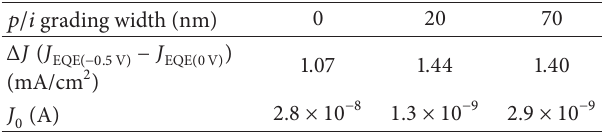
Table 1: The reverse saturation current ( 𝐽 0 ) and the difference of current densities ( Δ𝐽 ) measured with bias voltages of 0 and − 0.5 V in EQE as a function of the p/i grading